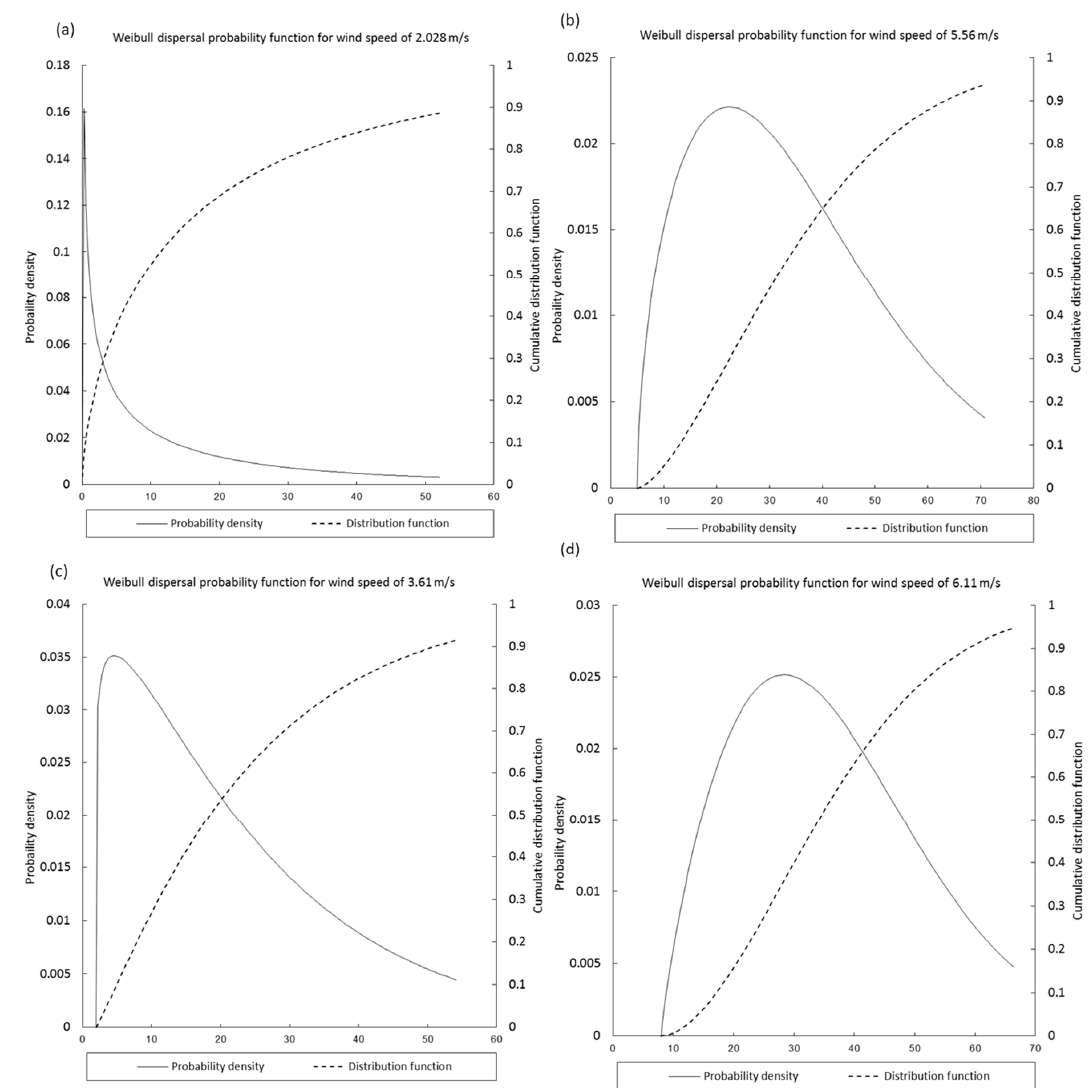
Figure 5. Weibull seed dispersal probability distributions at wind speeds ( a ) 2.028 m/s; ( b ) 5.56 m/s; ( c ) 3.61 m/s; ( d ) 6.11 m/s.